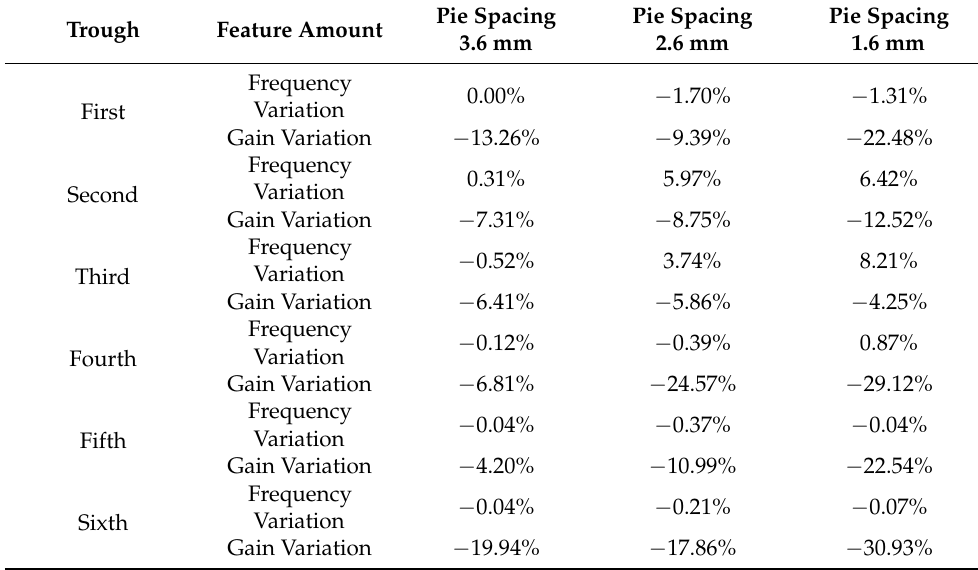
Table 13. Variation in valley frequency and amplitude